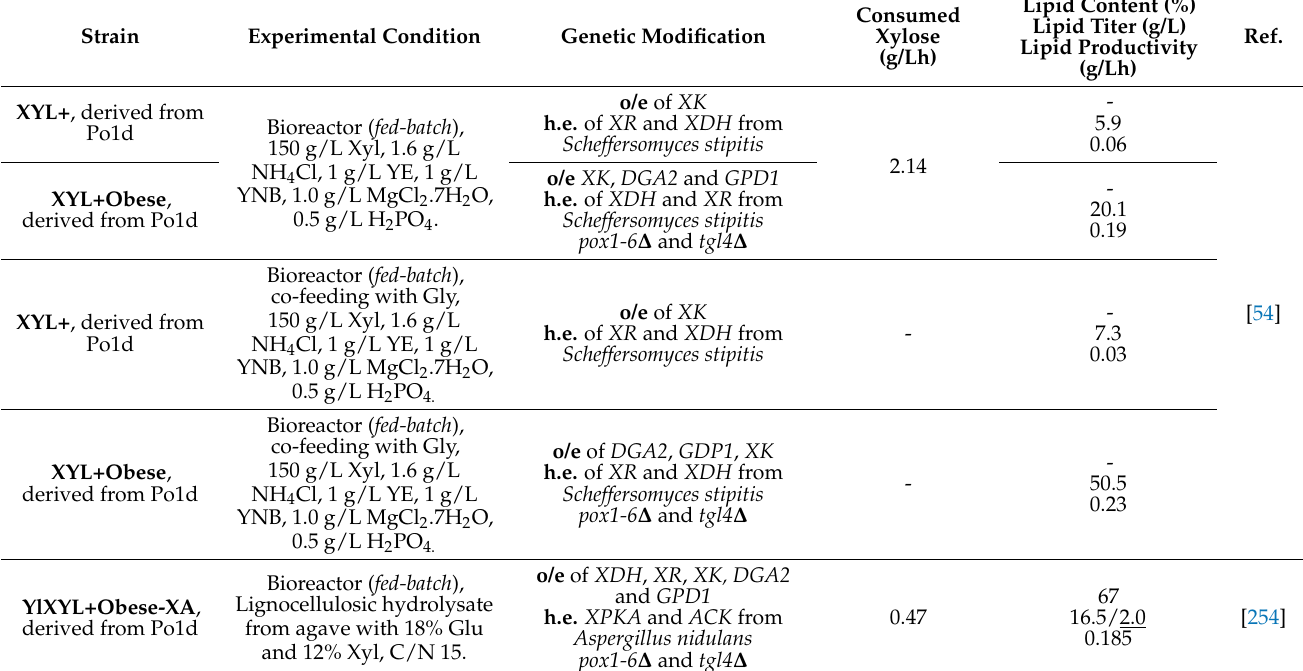
Table 7. Genetic modifications performed in Yarrowia lipolytica to improve xylose consumption. Strains of Y. lipolytica that are not genetically manipulated and not able to use xylose as C-source are considered controls. The meaning of the abbreviations used is explained at the end of the table. The underlined values correspond to the lipid production parameters obtained for the parental